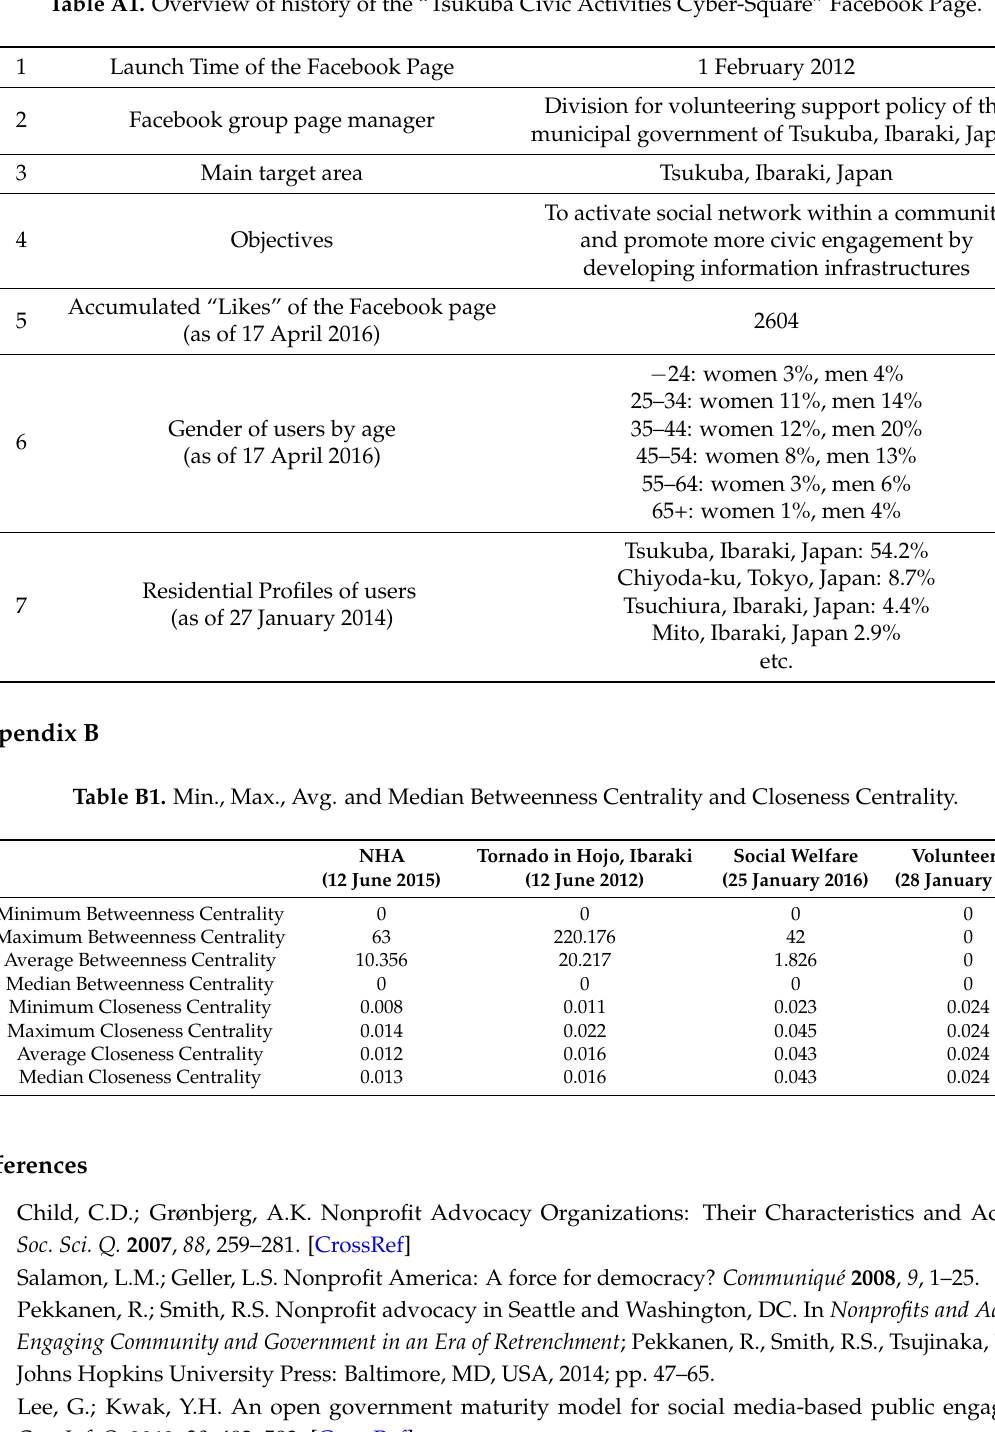
Table A1. Overview of history of the “Tsukuba Civic Activities Cyber-Square” Facebook Page.